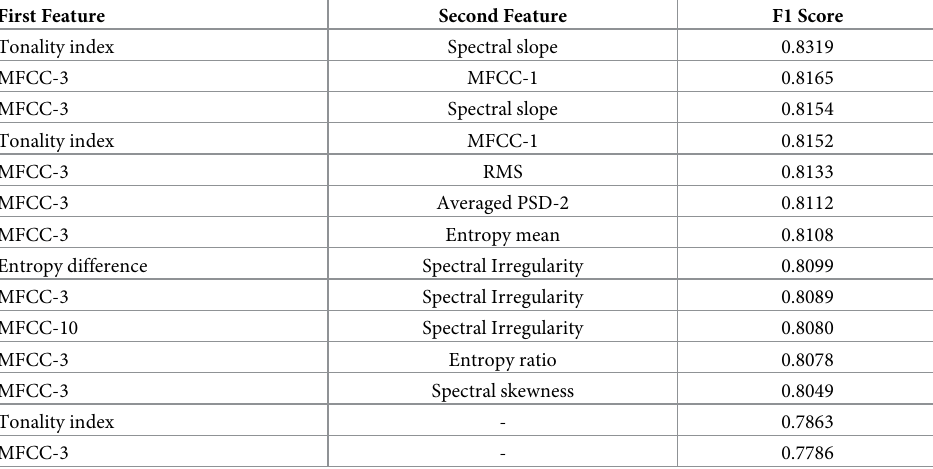
Table 9. F1 score of the best pairs of features for wheeze and normal sound classification using logistic regression on the